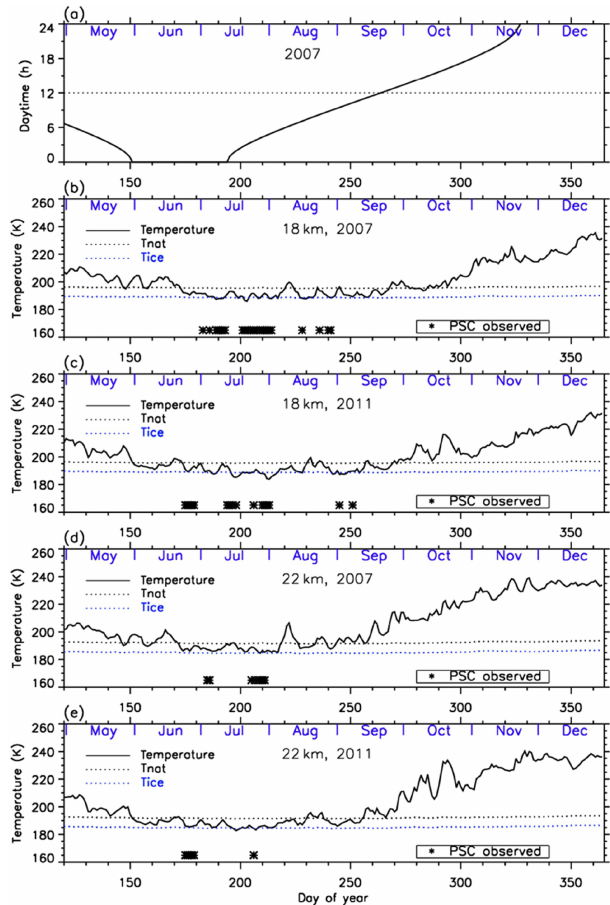
Figure 3. Time series of (a) daytime hour and temperatures at 18km in (b) 2007 and (c) 2011 and at 22km in (d) 2007 and (e) 2011 over Syowa Station using ERA-Interim data. Approximate satura- tion temperatures for nitric acid trihydrate ( T NAT ) and ice ( T ICE ) calculated by assuming 6ppbv HNO 3 and 4.5ppmv H 2 O are also plotted in the figures by dotted lines. Dates when PSCs were ob- served over Syowa Station are indicated by asterisks on the bottom of the